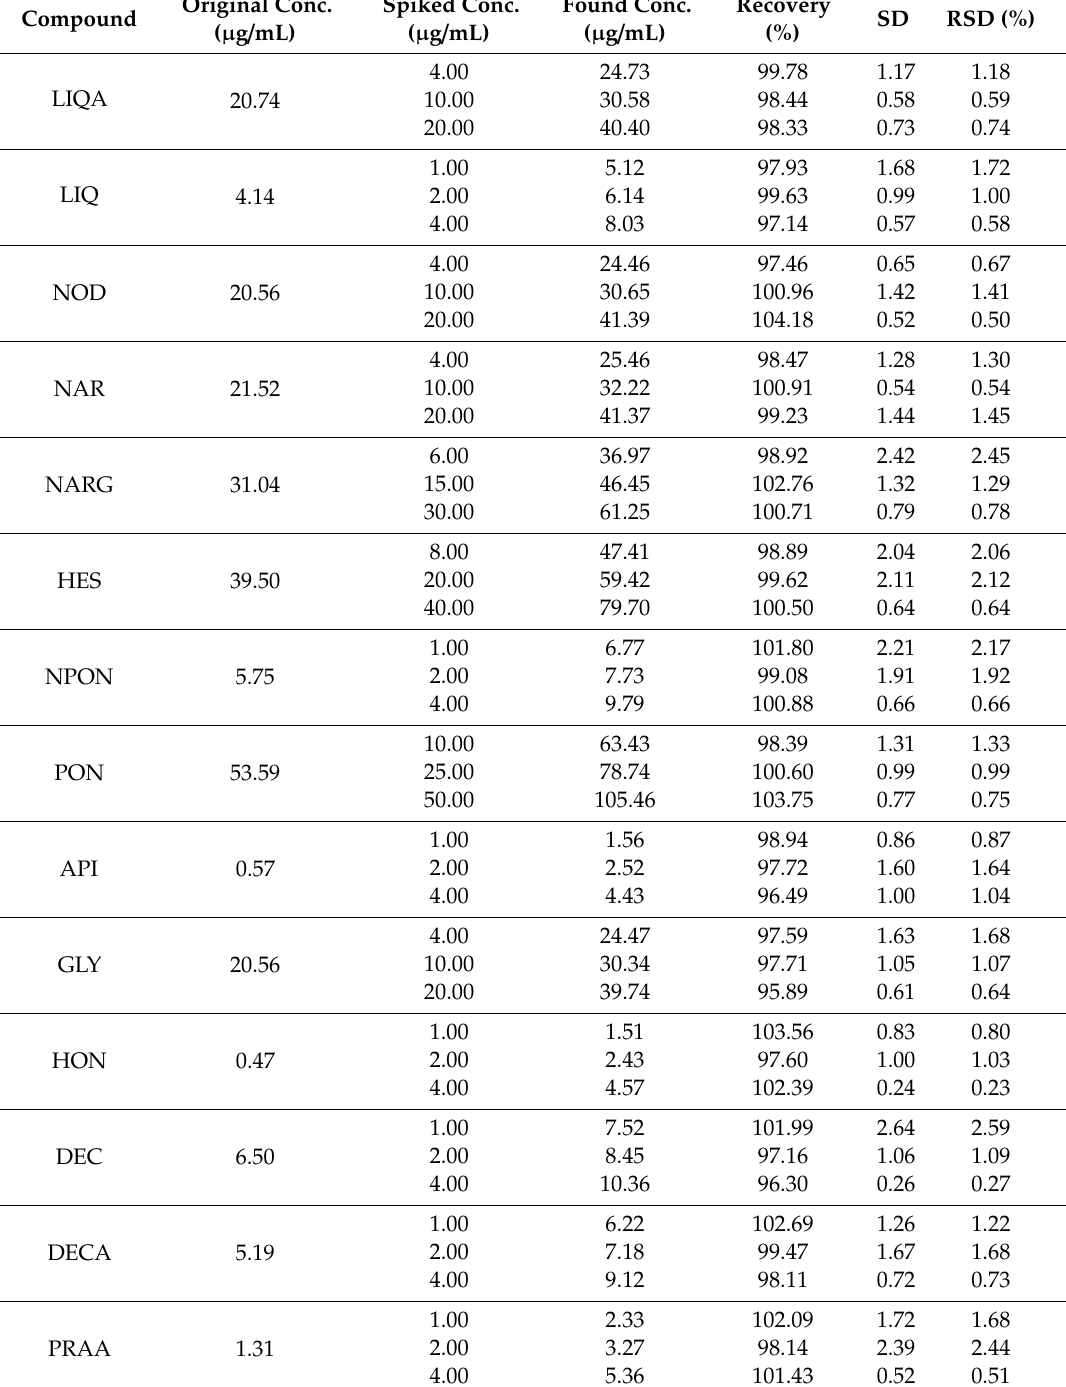
Table 2. Recovery test for the assay of 14 components in SDGT using HPLC–PDA. Original Conc. Spiked Compound